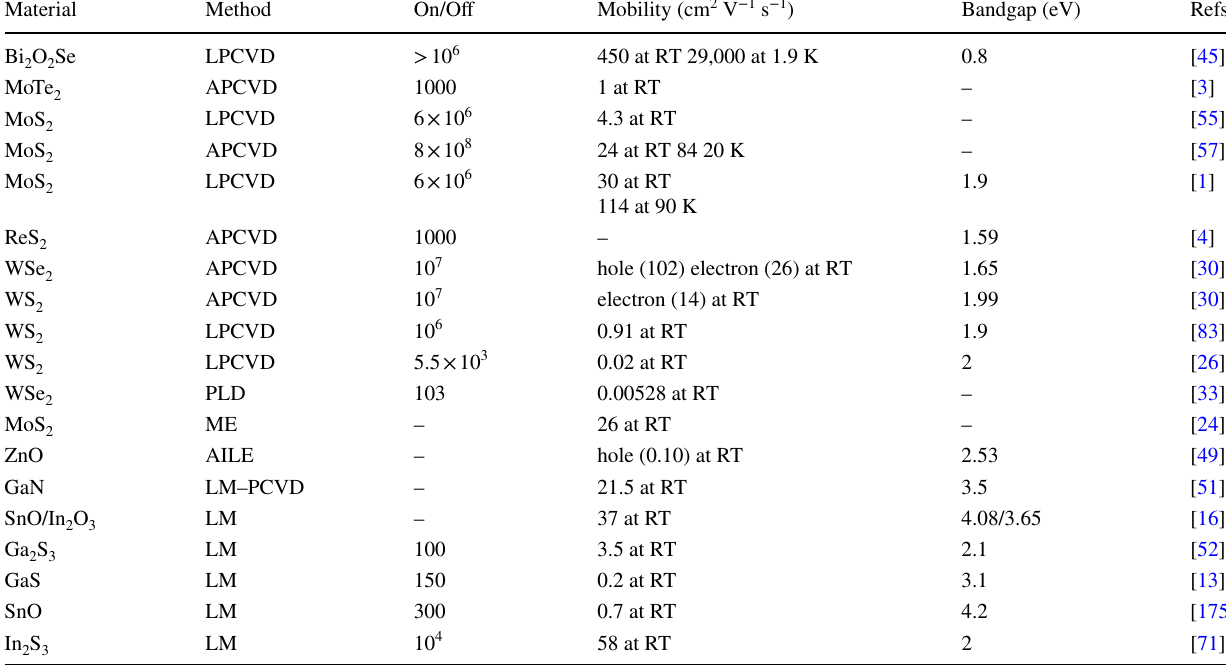
Table 1 Electrical performances of large-area 2D materials Material